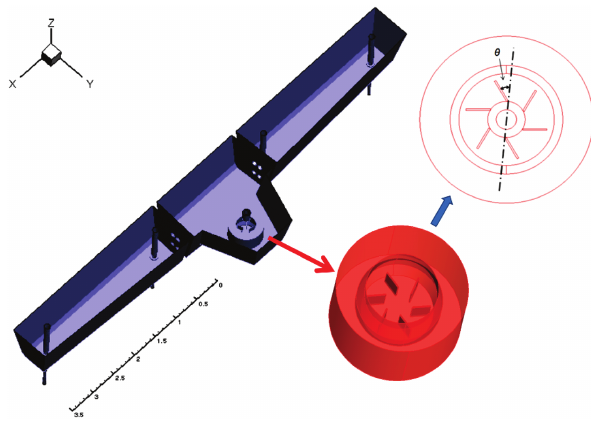
Table 1: The configuration of the tundish.